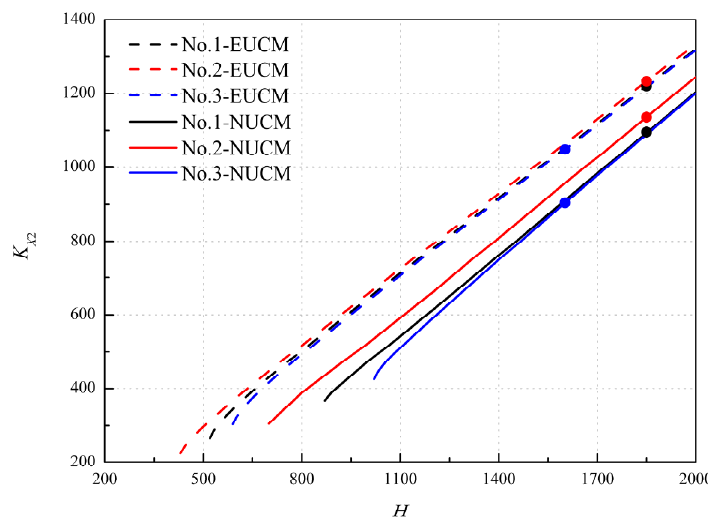
Figure 4. The bistability curves at different scalar factor.